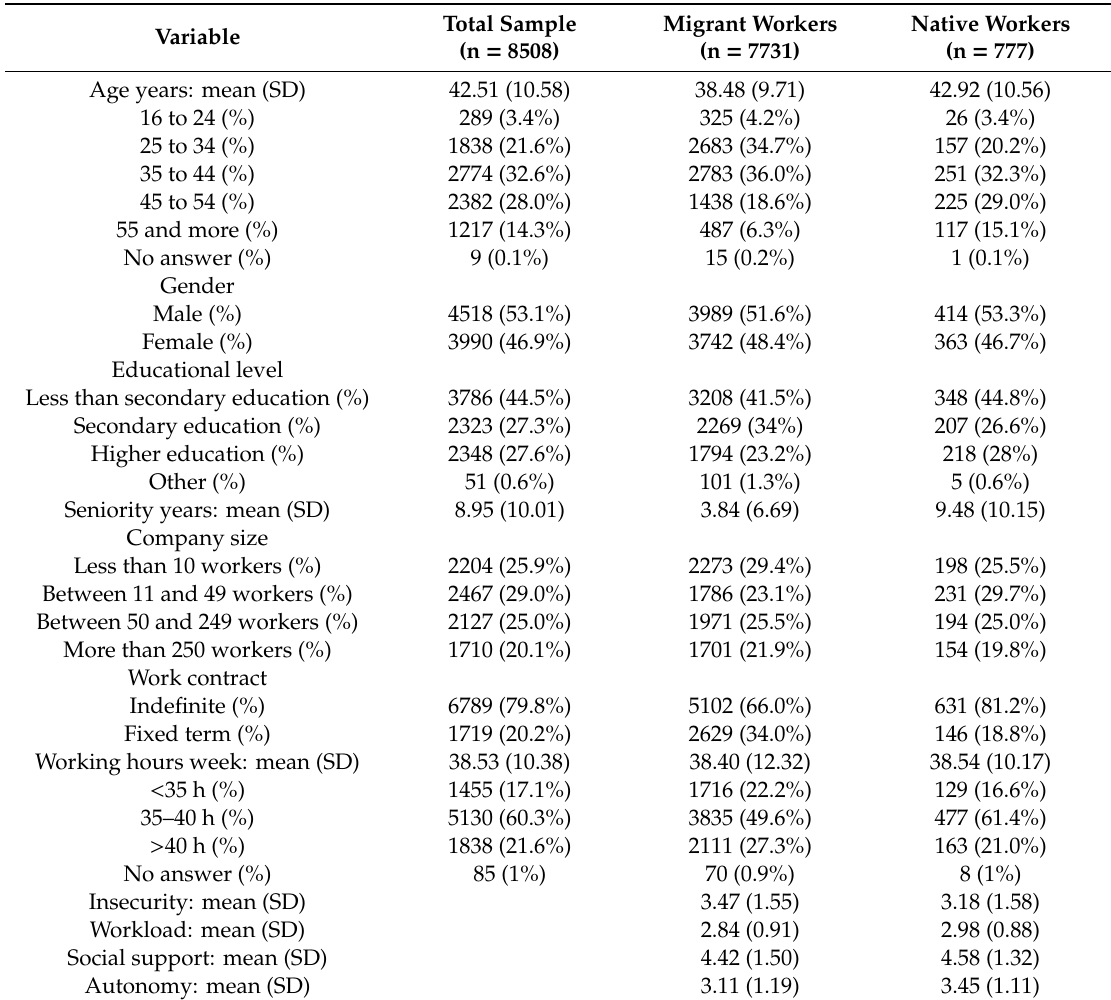
Table 2. Descriptive analysis of sociodemographic variables among migrant workers and native